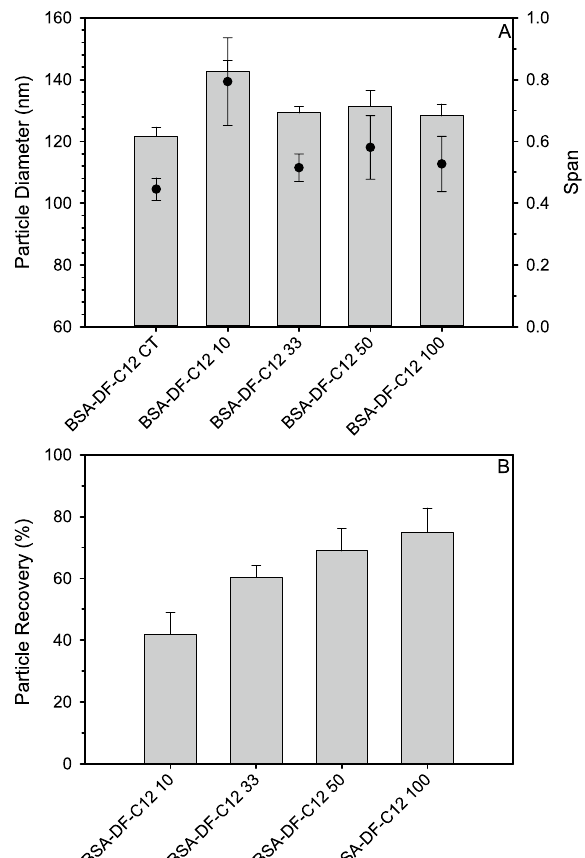
Figure 3. ( A ) Plots of mean diameter (grey bars) and Span (black circles) pre freeze-drying (BSA-DF-C12) and after reconstitution at various particle concentrations for BSA nanoparticles fabricated with dodecanoic acid loaded protein. ( B ) Plot of particle recovery for freeze-dried BSA-DF-C12 nanoparticles at different concentrations upon reconstitution. Data represents mean values from three measurements and error bars represent the standard deviation.